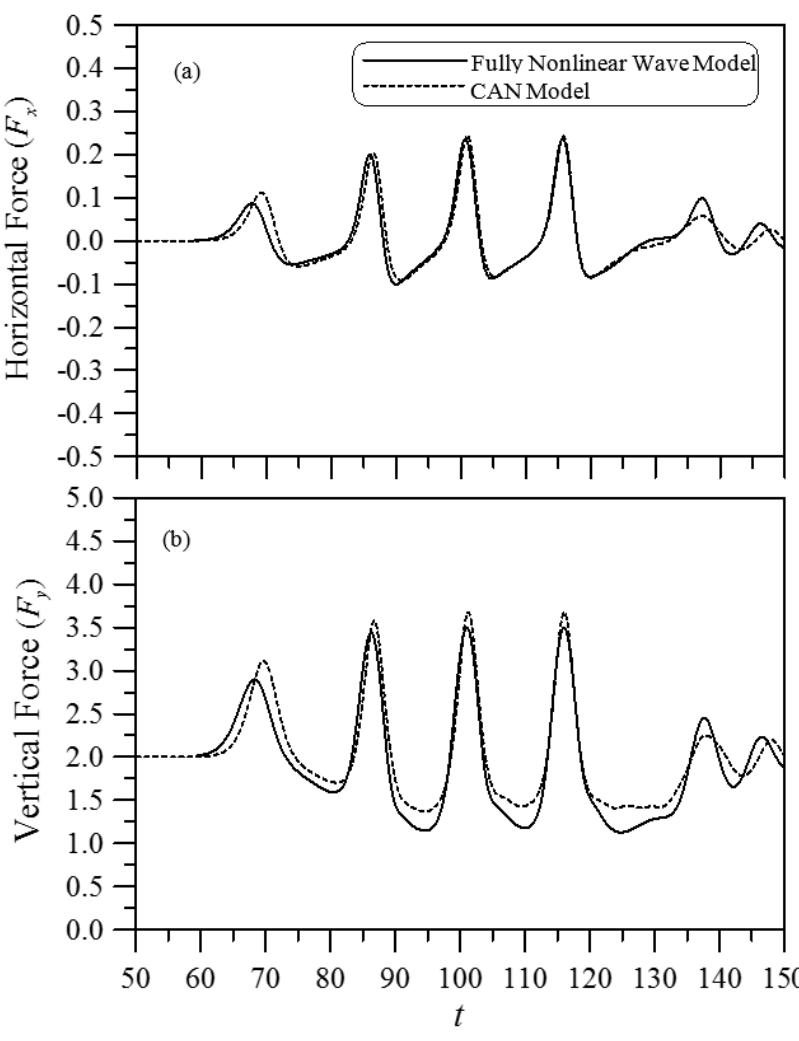
Figure 7. Comparisons of time variations of the dimensionless horizontal force in ( a ) and dimen- sionless vertical force in ( b ) obtained from the present CAN model and FNWM under the wave and structural conditions of α = 0.3, λ = 15, L = 4, and h 1 = 0.5.